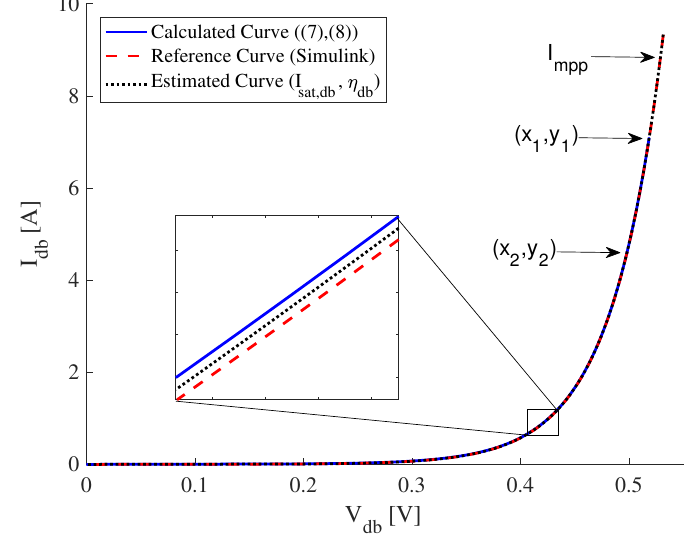
Figure 10. I-V curves of the bypass diode obtained with Simulink (red dashed line), using (7) and (8) (blue continuous line), and applying the proposed procedure (black dotted